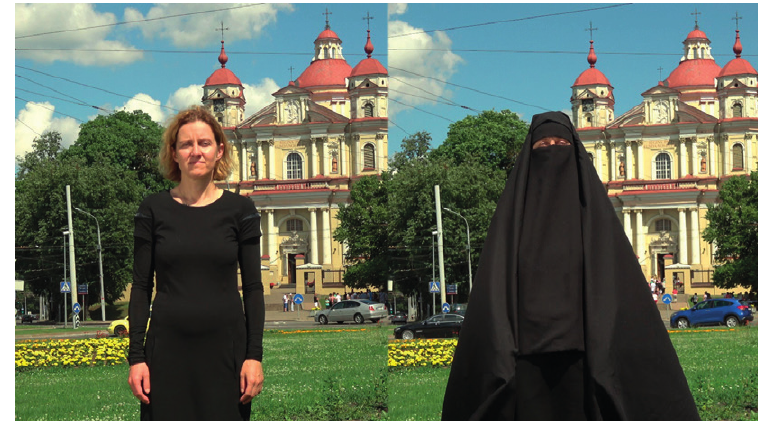
Figure 7. Sigita Maslauskaitė-Mažylienė. Partition: Niqab